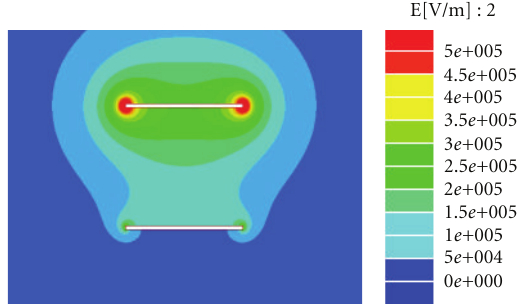
Figure 3: Field produced by FEMM balloon boundary.